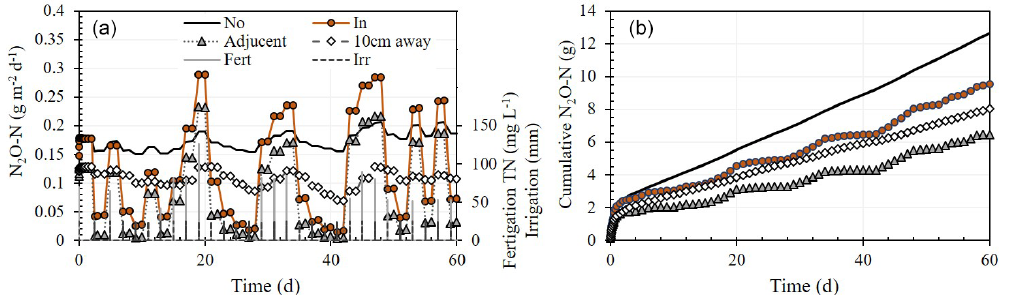
Figure 7. Simulation results of (a) daily and (b) cumulative N 2 O-N emissions from the soil surface under (No) and 10cm away from a dripper without a chamber base, from a chamber base with a dripper at its center (In), and a base adjacent to the dripper (adjacent), during consecutive fertigation events over a period of 60d.